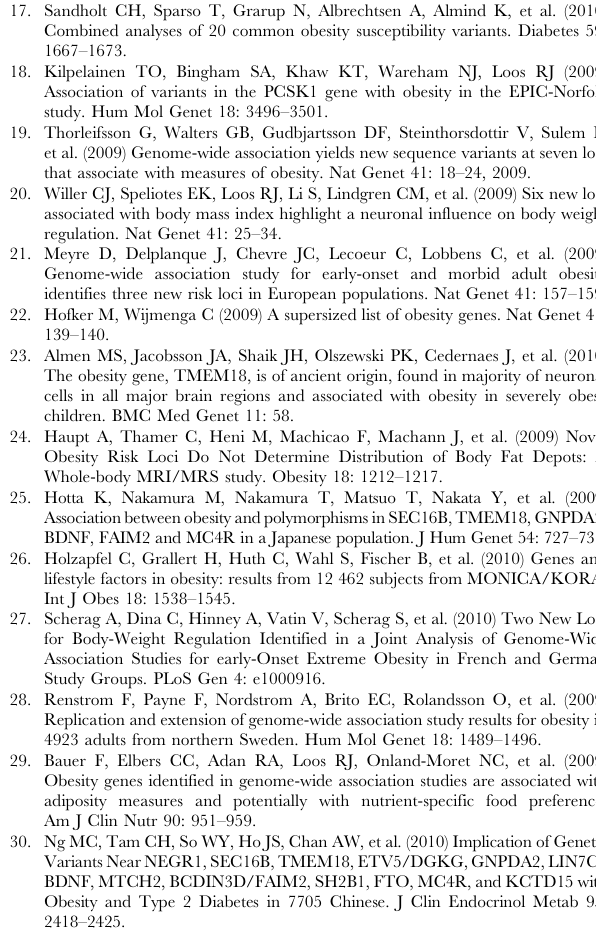
Table S3 Statistical power calculations of quantitative traits. Table S4 Case-control studies of overweight, obesity and type 2 diabetes in the combined study sample. Table S5 Anthropometric and metabolic measures